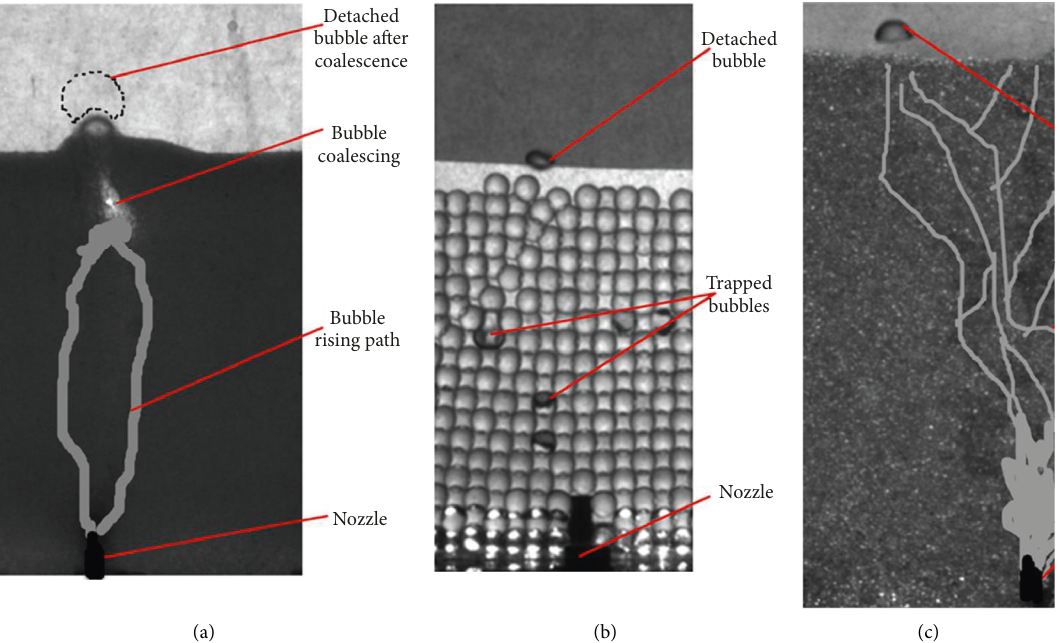
Figure 5: Typical bubble behaviors within particle beds [31] (a) Bubble coalescing regime (glass particles, dp =0.4mm) (b) Bubble trapping regime (glass particles, dp =6mm) (c) Transitional regime (glass particles, dp =1mm).